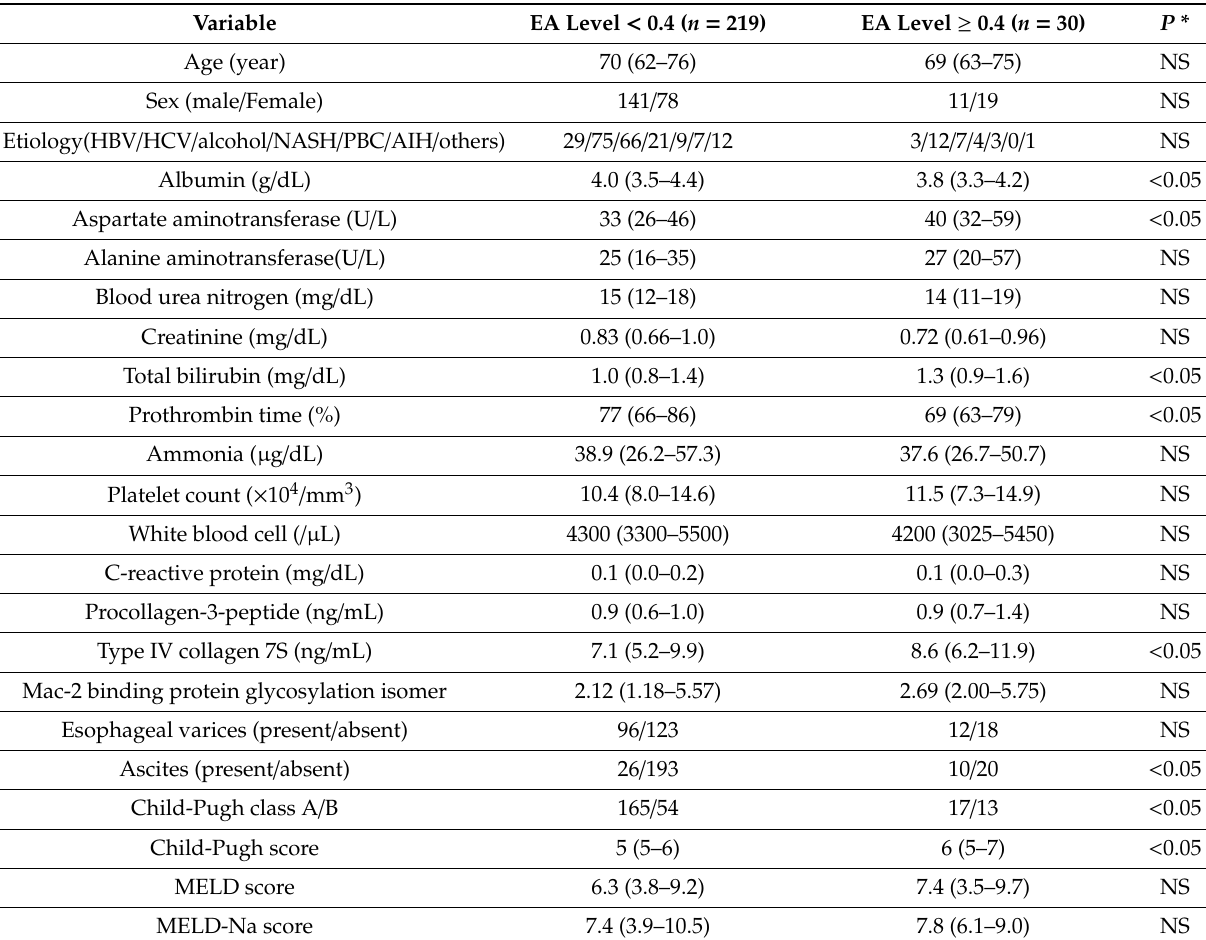
Table 2. EA level and patient